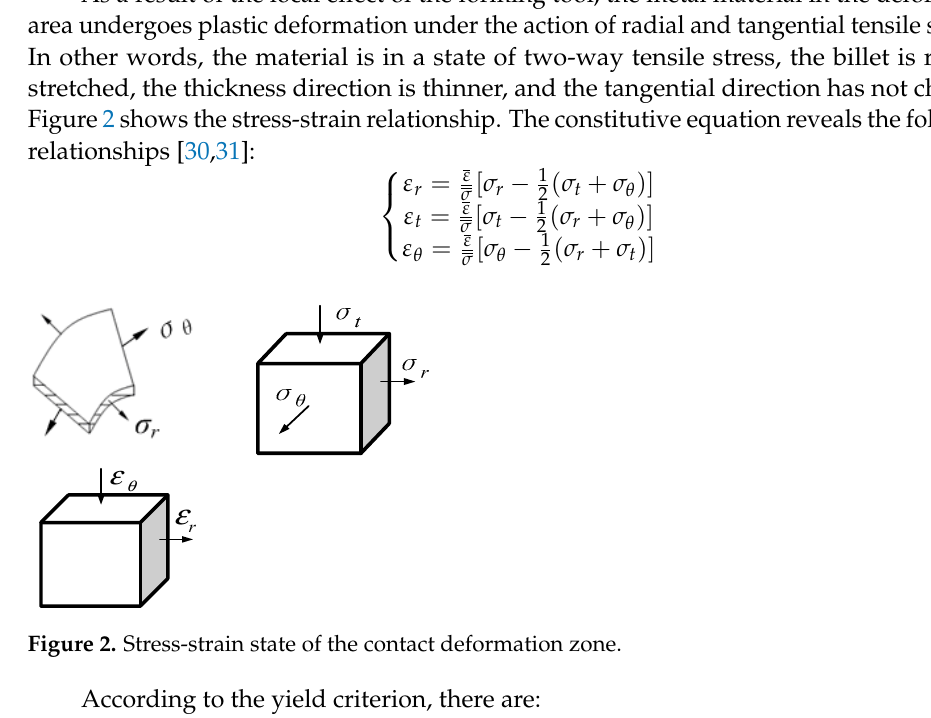
Figure 1. Progressive forming mechanism.